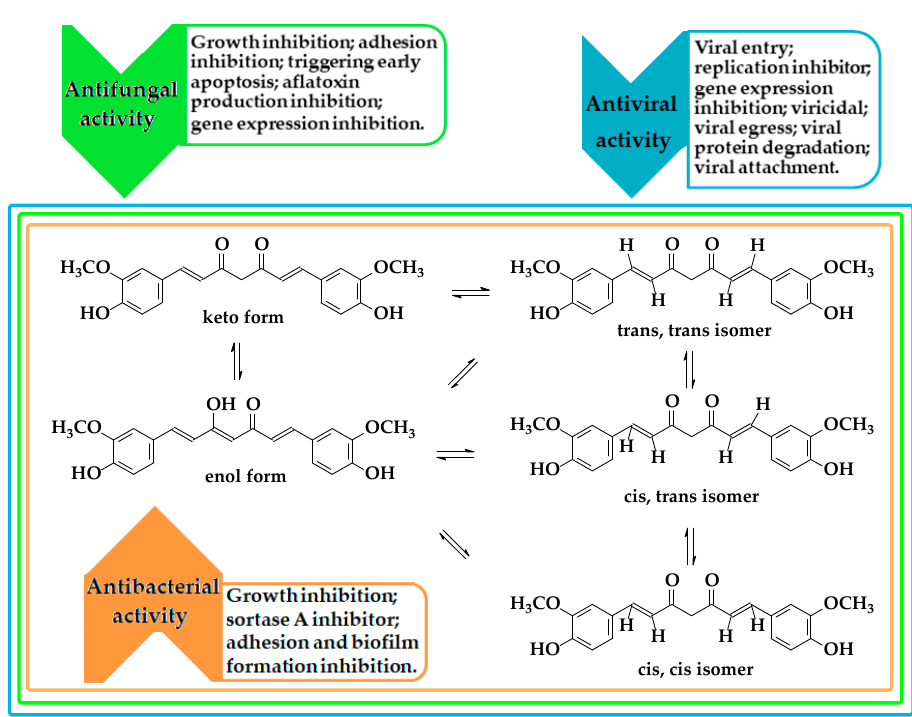
Figure 3. Isomeric forms and mechanisms by which curcumin manifests some of its